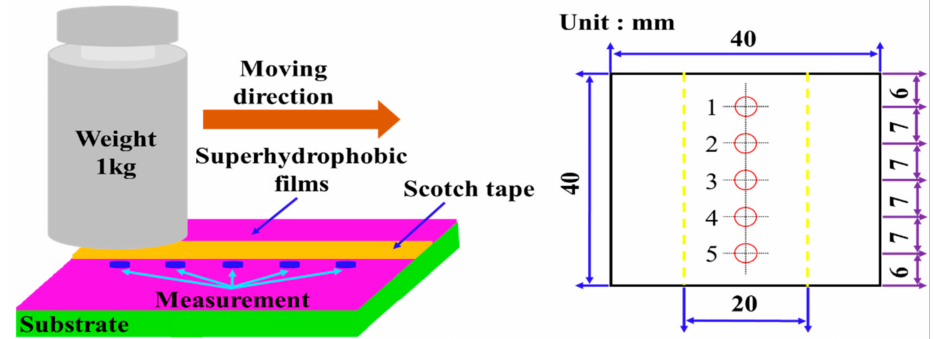
Figure 7. Schematic diagram of the scotch tape test for the fabricated superhydrophobic coated films and the five wettability measurement positions.